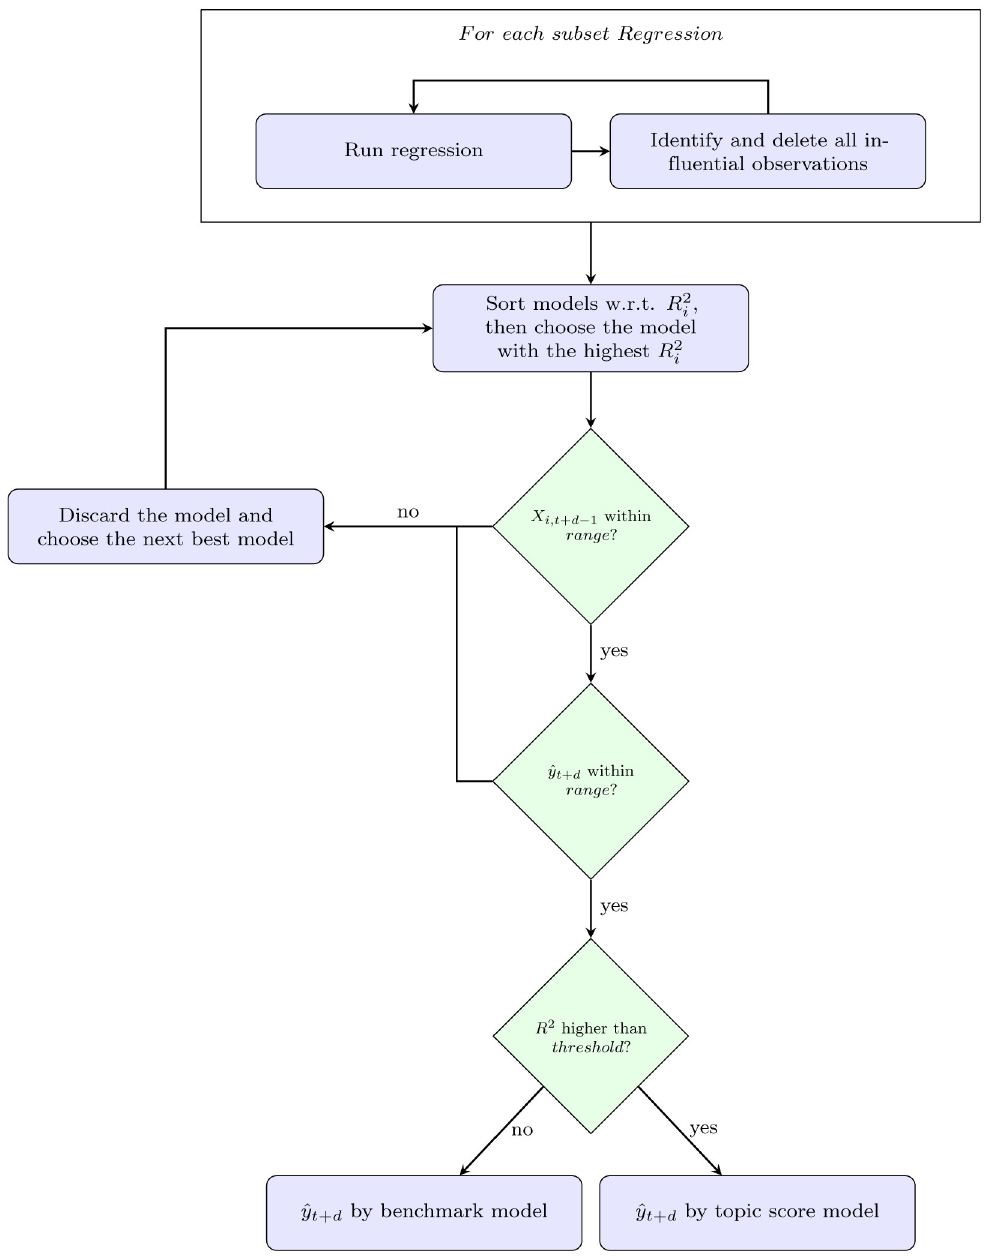
Fig 7. Regression flow chart. Decision rules for whether to choose the benchmark model or topic score model for prediction.